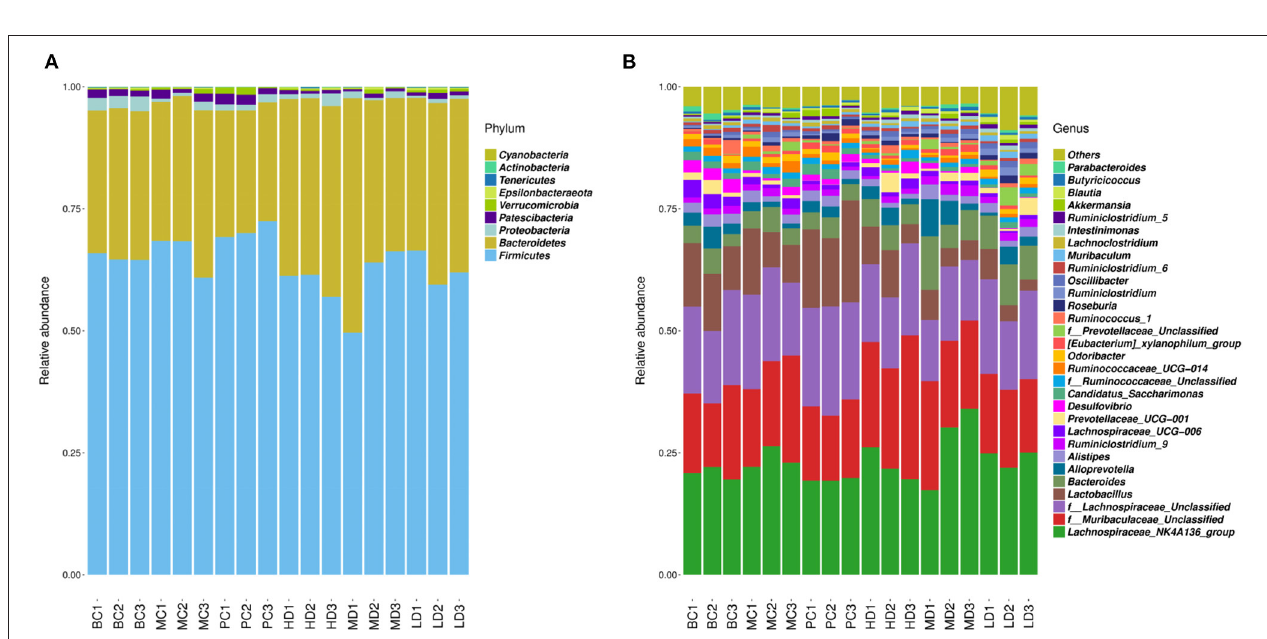
FIGURE 7 | Effect of F. velutipes polysaccharide on the expression levels of TFRC and RSAD2 proteins in mouse spleen. Compared with BC group: *** P < 0.001; Compared with MC group: ### P < 0.001.